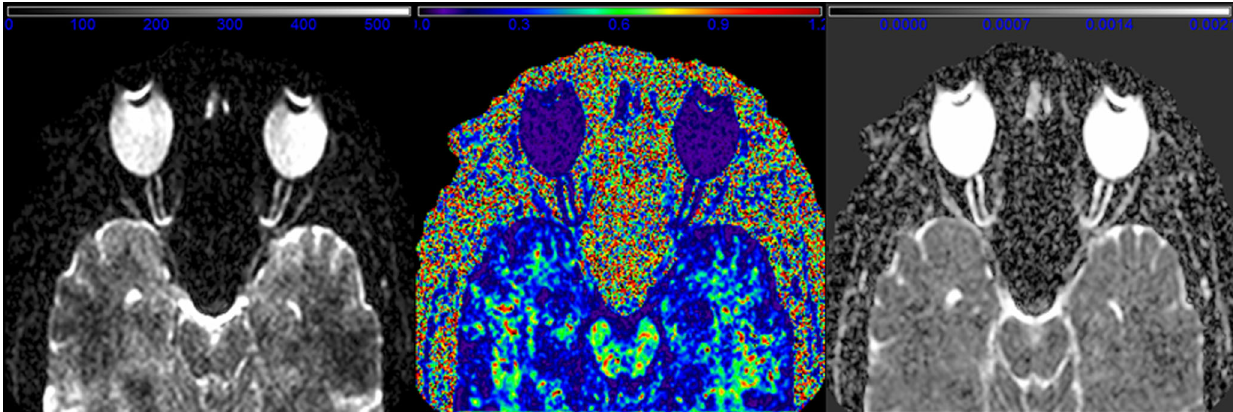
Fig. 2 Sagittal oblique middle cut slice of orbital DTI of one subject. Left: non-diffusion weighted image with arbitrary grayscale, middle: fractional anisotropy (FA) map (colorbar ranges from 0 to 1.2), right: mean diffusivity (MD) map; diffusion intensity values are given in 10 − 6 mm 2